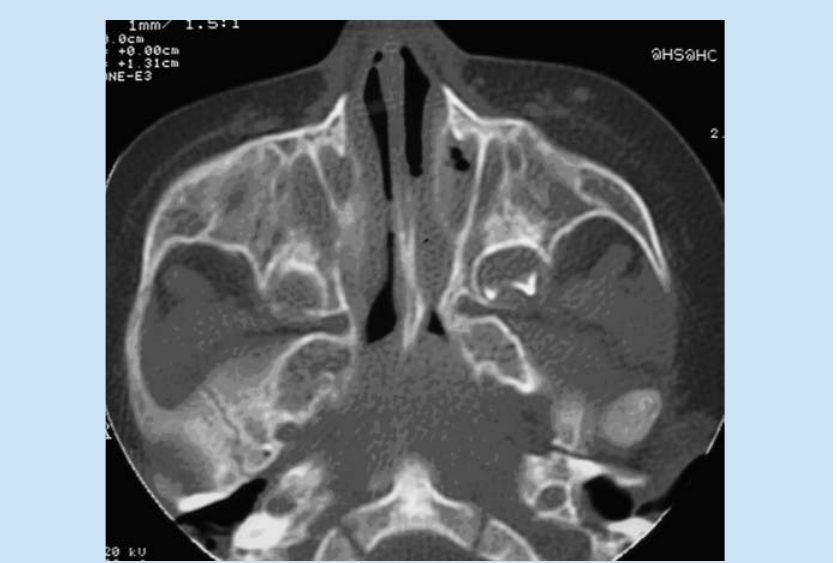
Fig. 2. CT scan showing unilateral left-sided stenosis with unilateral thickening of the vomer and medially bowed left medial maxillary